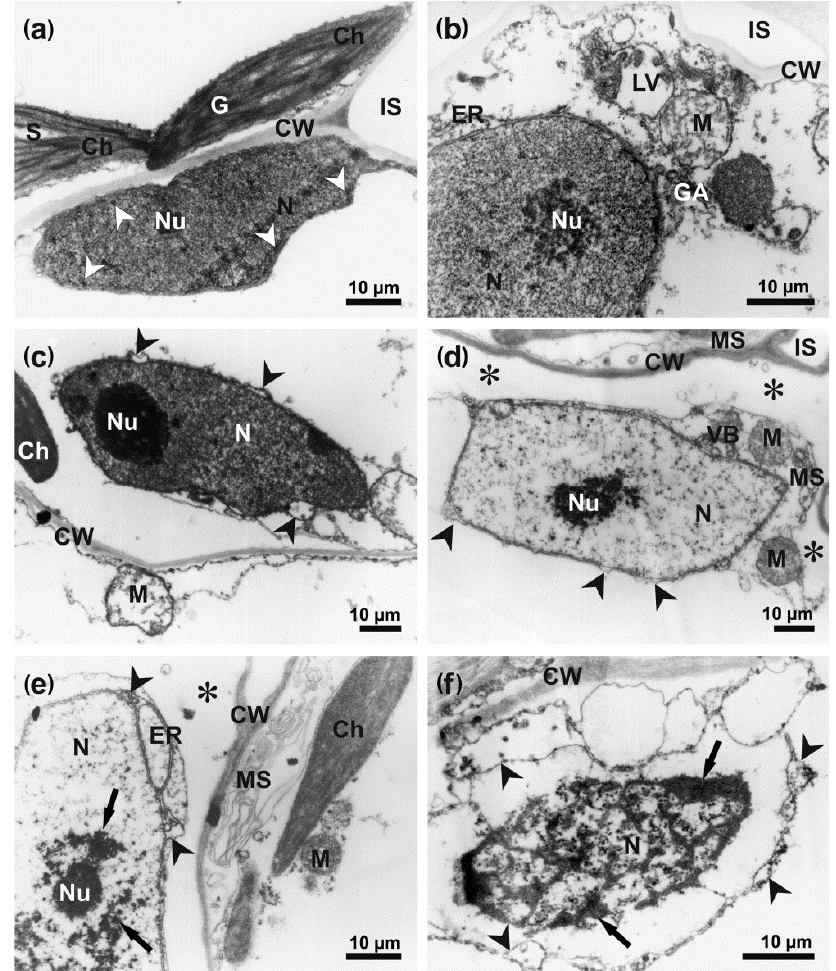
Figure 5. Degradation of mesophyll cells in B. oleracea leaf infected with A. brassicicola at 48 hpi. The images were captured using TEM. ( a ) a typical nucleus with a nucleolus and small heterochromatin grains (arrowheads), and chloroplasts in control mesophyll cell; ( b ) fragment of cell with degraded protoplast and nucleus with well-preserved nucleolus and fine granular chromatin; ( c ) nucleus with a nucleolus, condensed clumped chromatin and locally dilating nuclear envelope (arrowheads); ( d ) fragment of cell with degraded protoplast detached from the cell walls (asterisks), nucleus with granular chromatin, locally dilated envelope (arrowheads) and electron-dense deteriorating nucleolus; ( e ) fragment of strongly degraded cell with protoplast detached from cell walls (asterisk), pycnotic stage nucleus with osmiophilic remnants of chromatin (arrows) and dilated nuclear envelope (arrowheads); ( f ) terminal stage of nucleus degradation with clumps of chromatin (arrows), broken and dilated envelope (arrowheads). Abbreviations: Ch—chloroplast, CW—cell wall, ER—endoplasmic